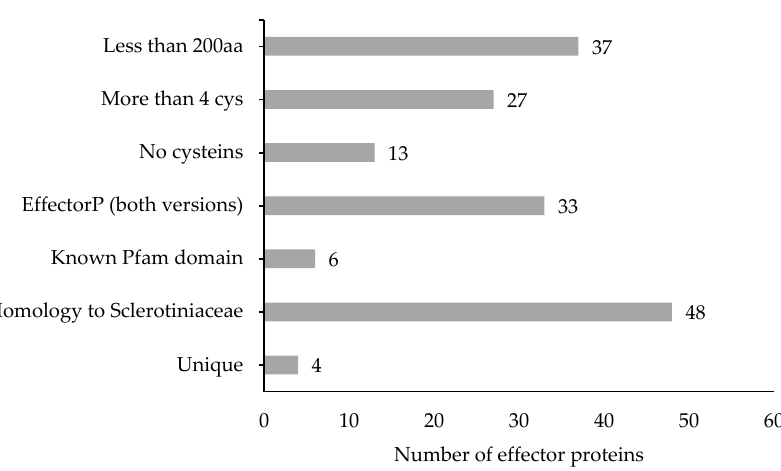
Figure 6. Characteristics of selected effector proteins.